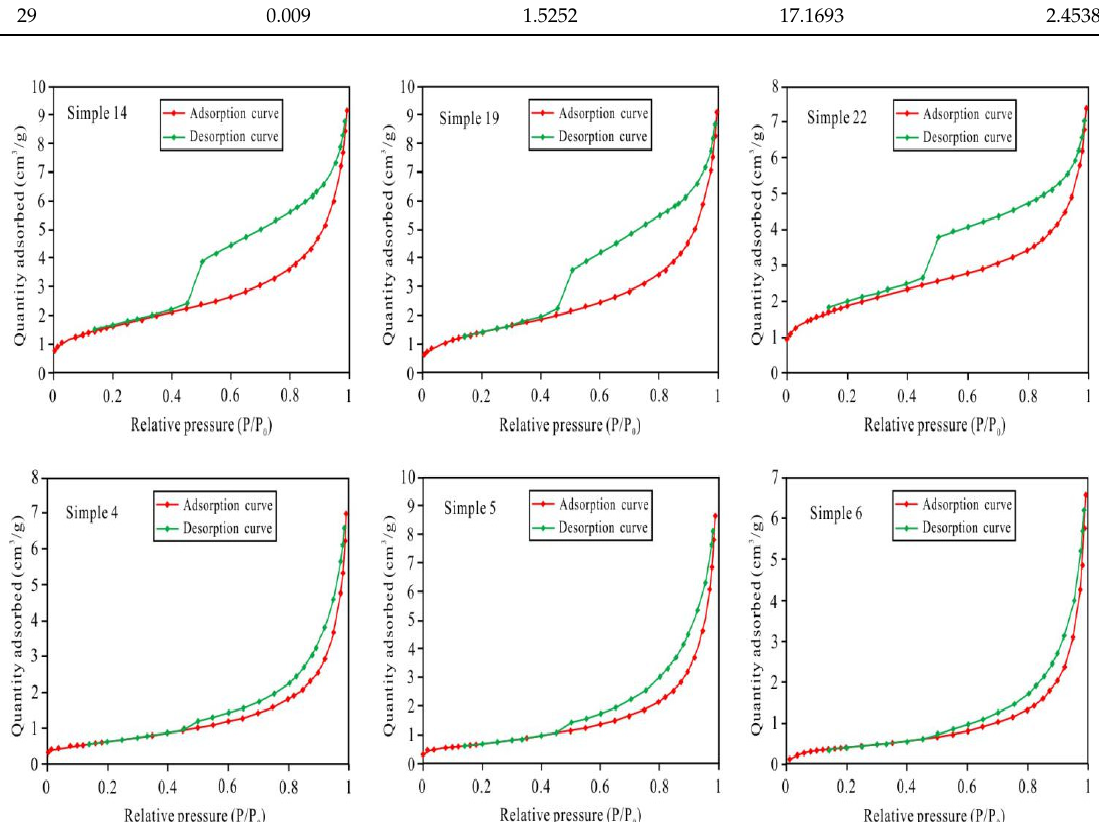
Figure 8. Adsorption–desorption curves of a part of the